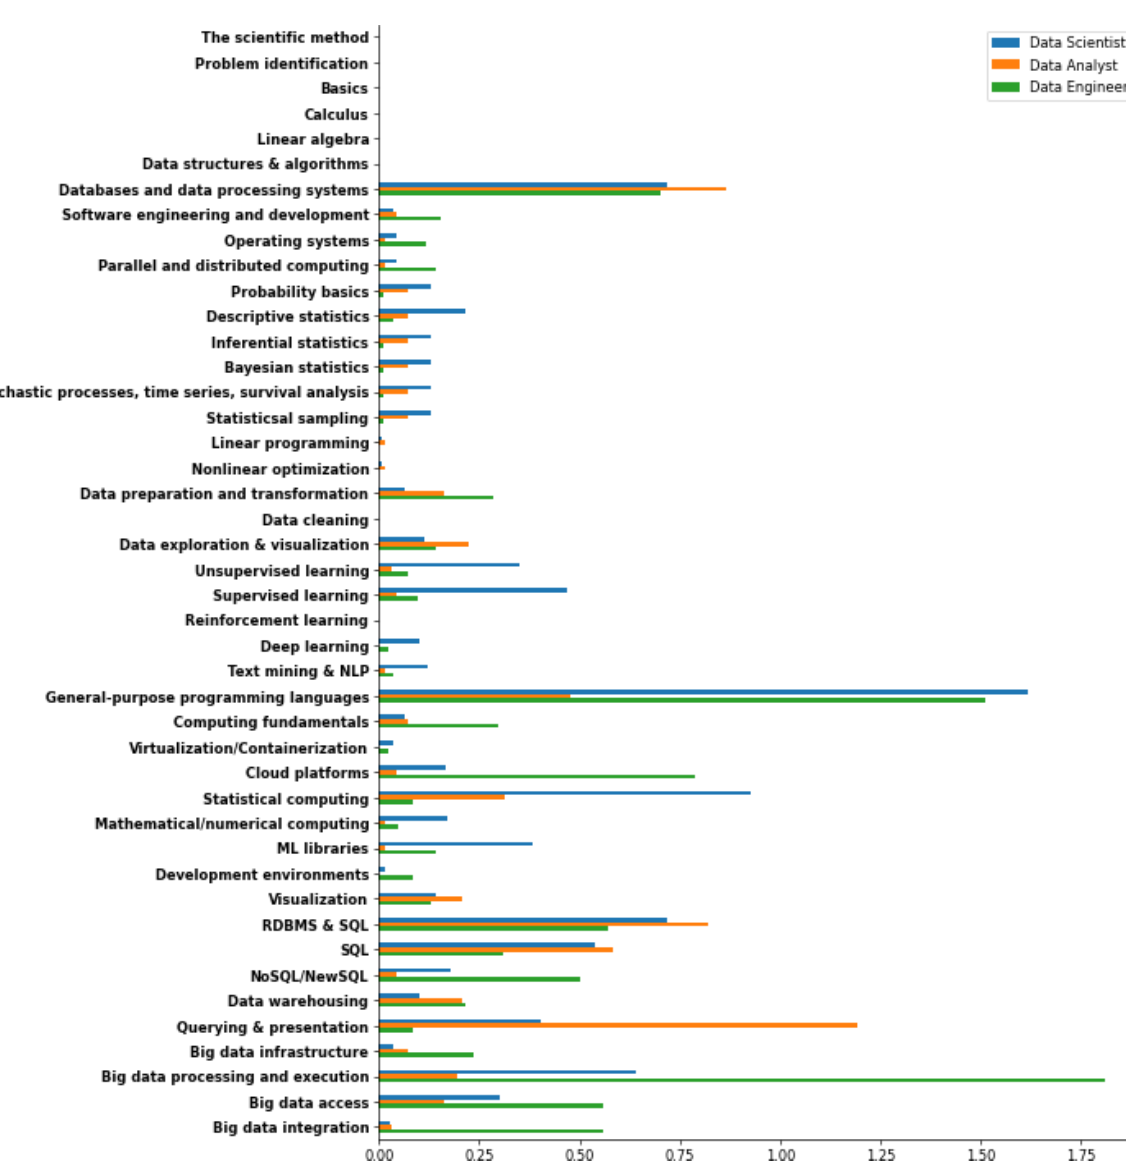
Figure B1a. The average frequency of key phrases found in LinkedIn job